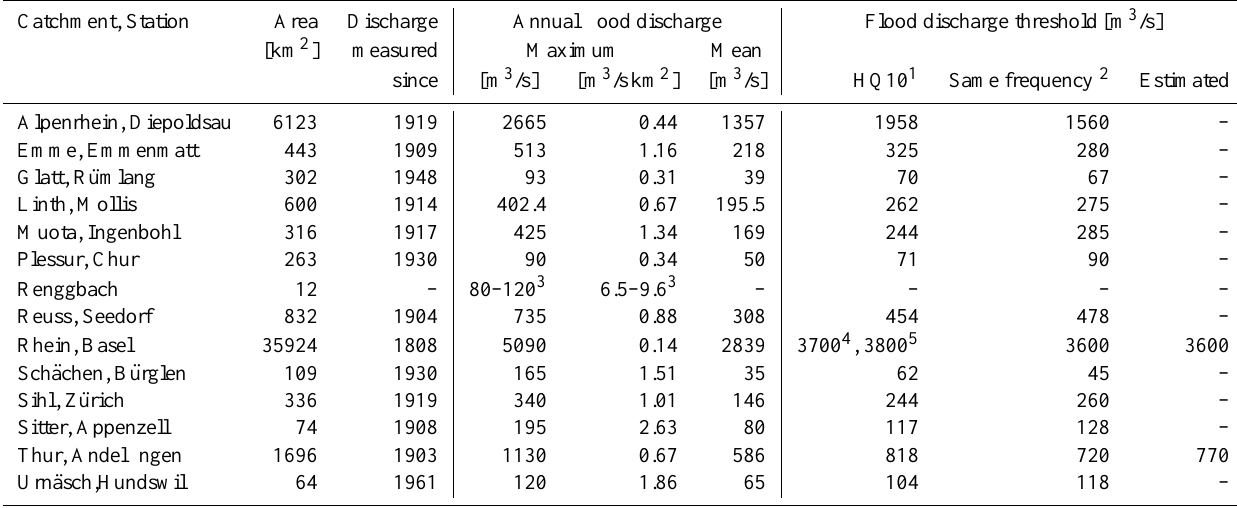
Table 1. Hydrologic parameters of the 14 catchments used in this study and the discharge thresholds above which a discharge is defined as a flood comparable to the historic floods.